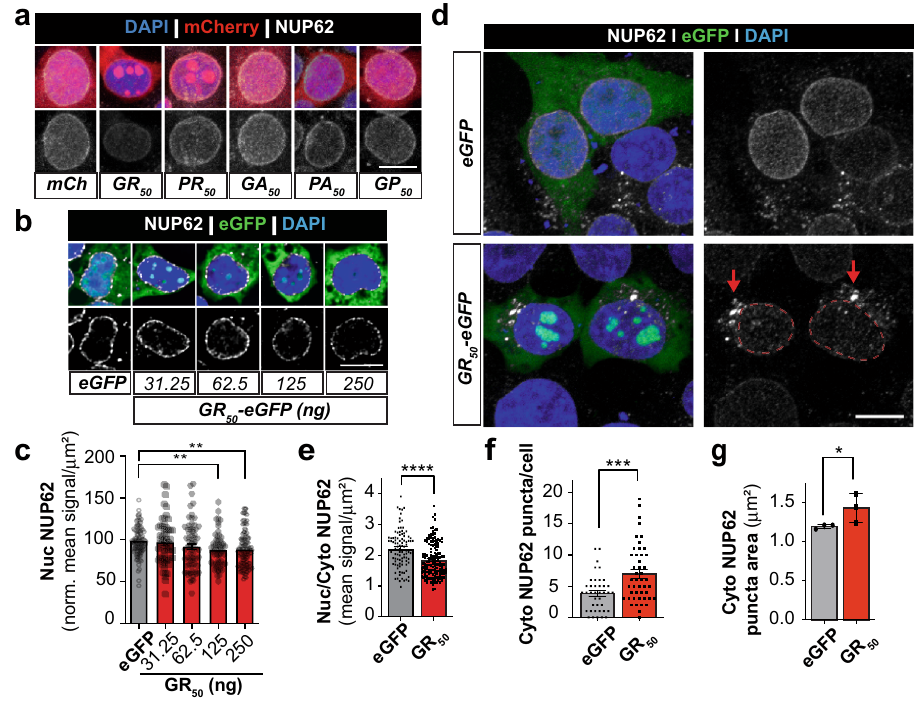
Fig. 3 Poly-GR alters NUP62 localization in vitro. a Nuclear NUP62 (white) levels were assessed in HEK293 cells expressing mCherry-tagged poly-DPR constructs (red) by immuno fl uorescent staining and confocal microscopy. Representative maximum intensity projection images are shown. Nuclear NUP62 quanti fi cation is shown in Supplemental Fig. 4a. Scale bar: 10 µ m. b HEK293 cells were transfected with increasing amounts of GR 50 -eGFP plasmid DNA and immunostained for NUP62. Image were processed by automatic deconvolution in Nikon Elements. Single slice images (0.2 µ m) of NUP62 (white) show dose-dependent reduction in nuclear NUP62 with increasing GR 50 -eGFP plasmid DNA. Scale bar: 10 µ m c Nuclear NUP62 signal was quanti fi ed in maximum intensity projection confocal images following immuno fl uorescent staining ( n = 104 (eGFP), 62 (31.25 ng), 71 (62.5 ng), 64 (125 ng), 120 (250 ng) cells per group). Data corresponds to images presented in Fig. 3b. Statistical signi fi cance was determined by one-way ANOVA with Dunnett ’ s multiple comparisons test. Data are shown as mean + /- SEM. d To assess whether GR 50 -eGFP alters NUP62 localization, HEK293 cells were transfected with eGFP or GR 50 -eGFP (green) and immunostained for NUP62 (white). Representative confocal images show nuclear NUP62 depletion that coincides with cytoplasmic NUP62 puncta accumulation. Nuclear compartment is highlighted by dashed red line and cytoplasmic NUP62 accumulations are indicated by red arrow. Scale bar: 10 µ m. e Quanti fi cation of nuclear/cytoplasmic (Nuc/Cyto) distribution of NUP62 signal corresponding to Fig. 3d representative images. Regions of interest (ROIs) were drawn around DAPI or cytoplasm signals to determine NUP62 in the respective regions. The distribution for each cell was determined and then averaged for n = 96 (eGFP) -138 (GR 50 ) cells across four independent experiments. Statistical signi fi cance was determined by unpaired two-tailed t-test. Data are shown as mean + /- SEM. f We identi fi ed cytoplasmic NUP62 puncta by spot detection (diameter 1 µ m or larger) methods and counted the frequency of these structures in each HEK293 cell (n = 39 (eGFP) - 47 (GR 50 ) cells). Quanti fi cation reveals an increased cytoplasmic NUP62 prevalence due to GR 50 expression. Statistical signi fi cance was determined by unpaired